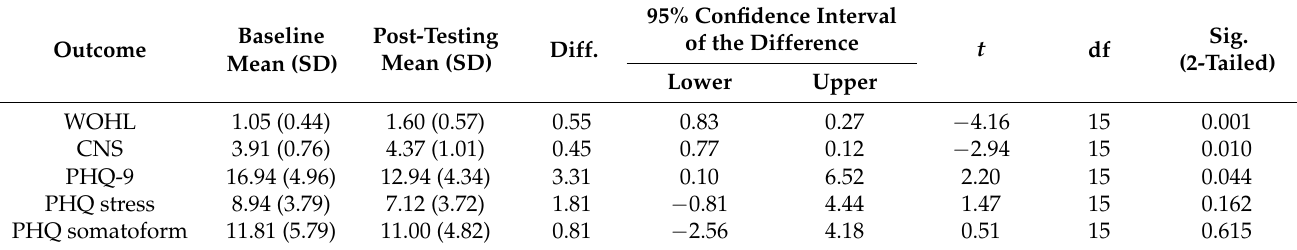
Table 2. Paired samples t -test of the baseline and post-testing